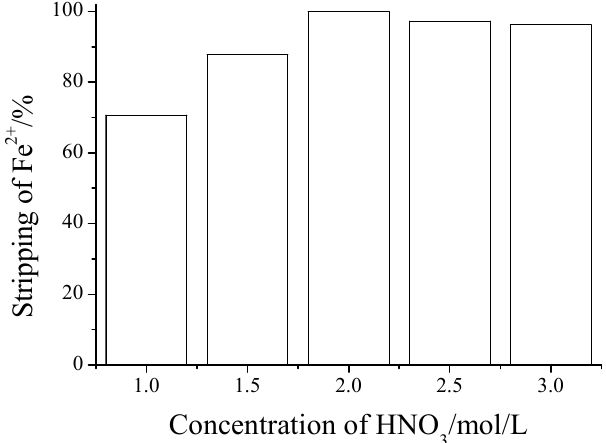
Figure 4. Stripping of Fe 2+ in TC-SLE system using different concentration of HNO 3 as stripping